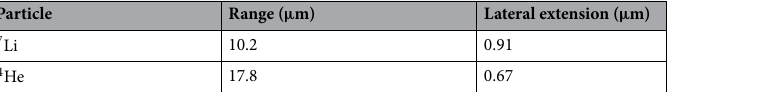
Table 1. Results from FLUKA simulations used for the affected volume estimation. Overall uncertainties are less than 5 % in all cases.